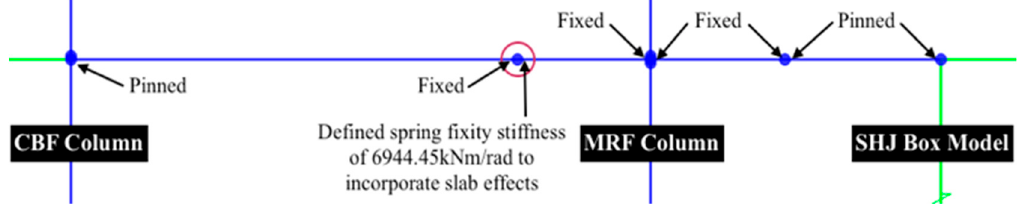
Figure 4. Rigid member partial fixity restraint conditions.